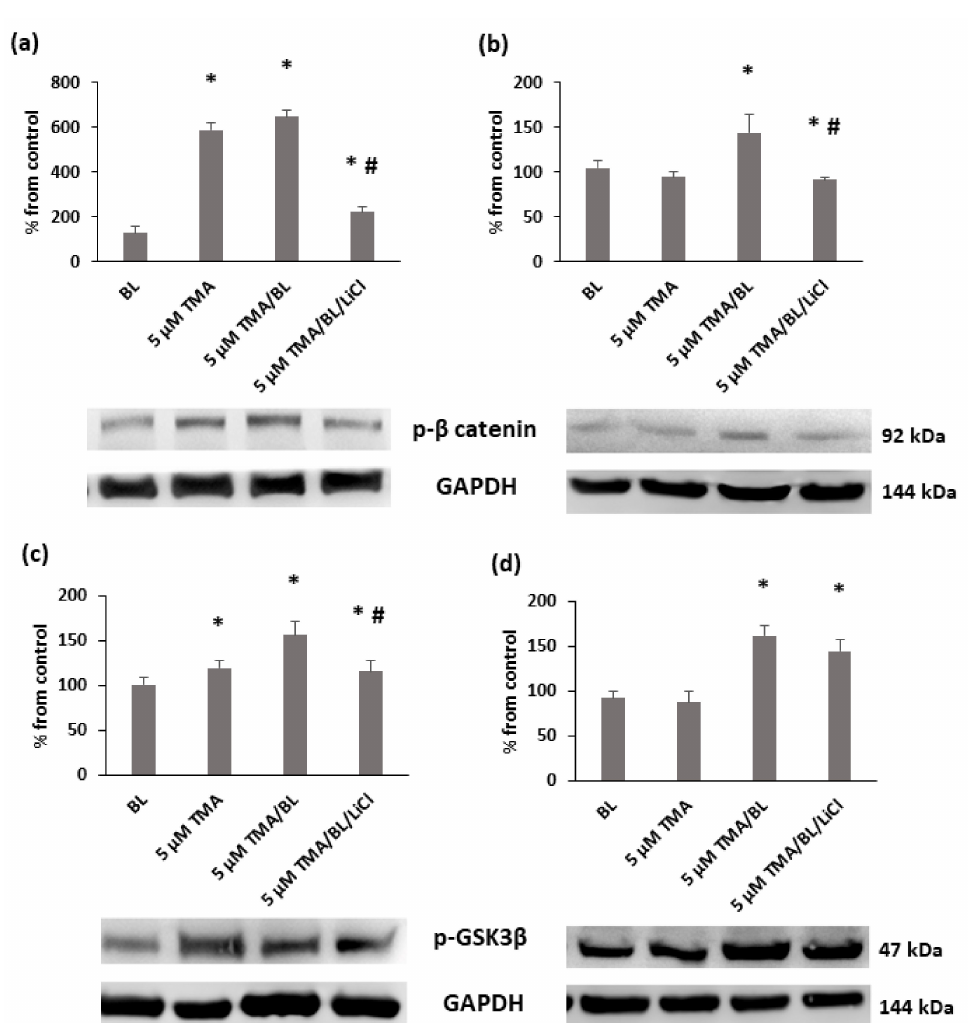
Figure 7. Western blot analysis of the phosphorylated forms of β -catenin ( a , b ) e GSK3 β ( c , d ) at 24 ( a , c ) and 48 h ( b , d ) after the treatment with TMA, BL (2 J/cm 2 ), and 1-mM LiCl. Quantification of the expression levels was carried out by a densitometric analysis using ImageJ software. Data are reported as percentages from the control cultures. * = p < 0.05 vs. the control cultures, # = p < 0.05 vs. the cultures treated with TMA/BL, Student’s t